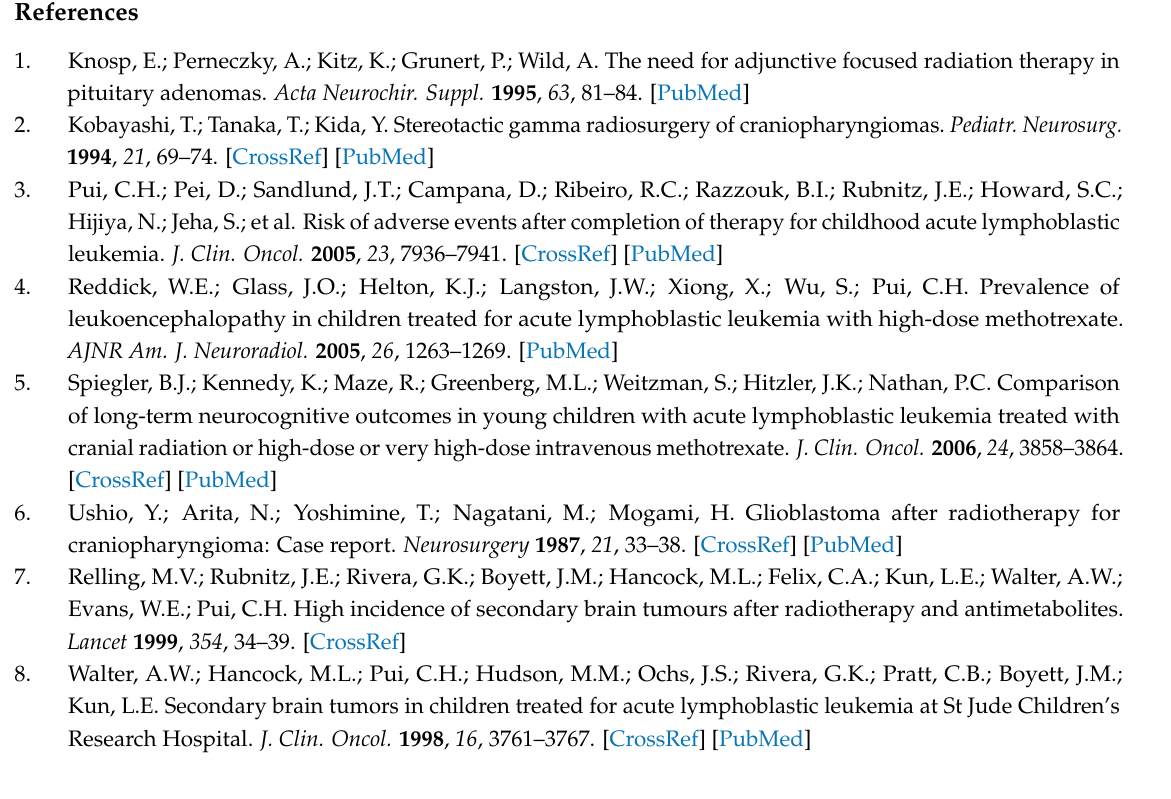
Table S1: Radiation-induced secondary intracranial tumor following radiotherapy for pituitary adenomas. Acknowledgments: This work was supported in part by KAKENHI grant (16H05441 to Ryuya YAMANAKA) from the Japan Society for the Promotion of Science. Conflicts of Interest: The authors declare that they have no conflict of